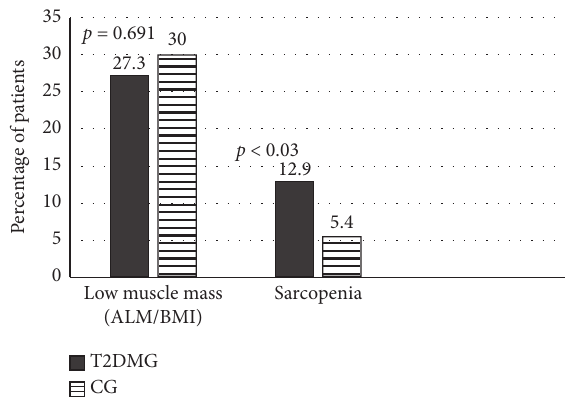
Figure 2: Prevalence of low muscle mass and sarcopenia in T2DMG and CG; abbreviations: T2DMG, T2DM group; CG, control group; ALM, appendicular muscle mass; BMI, body mass index; ( p ) statistically significant <